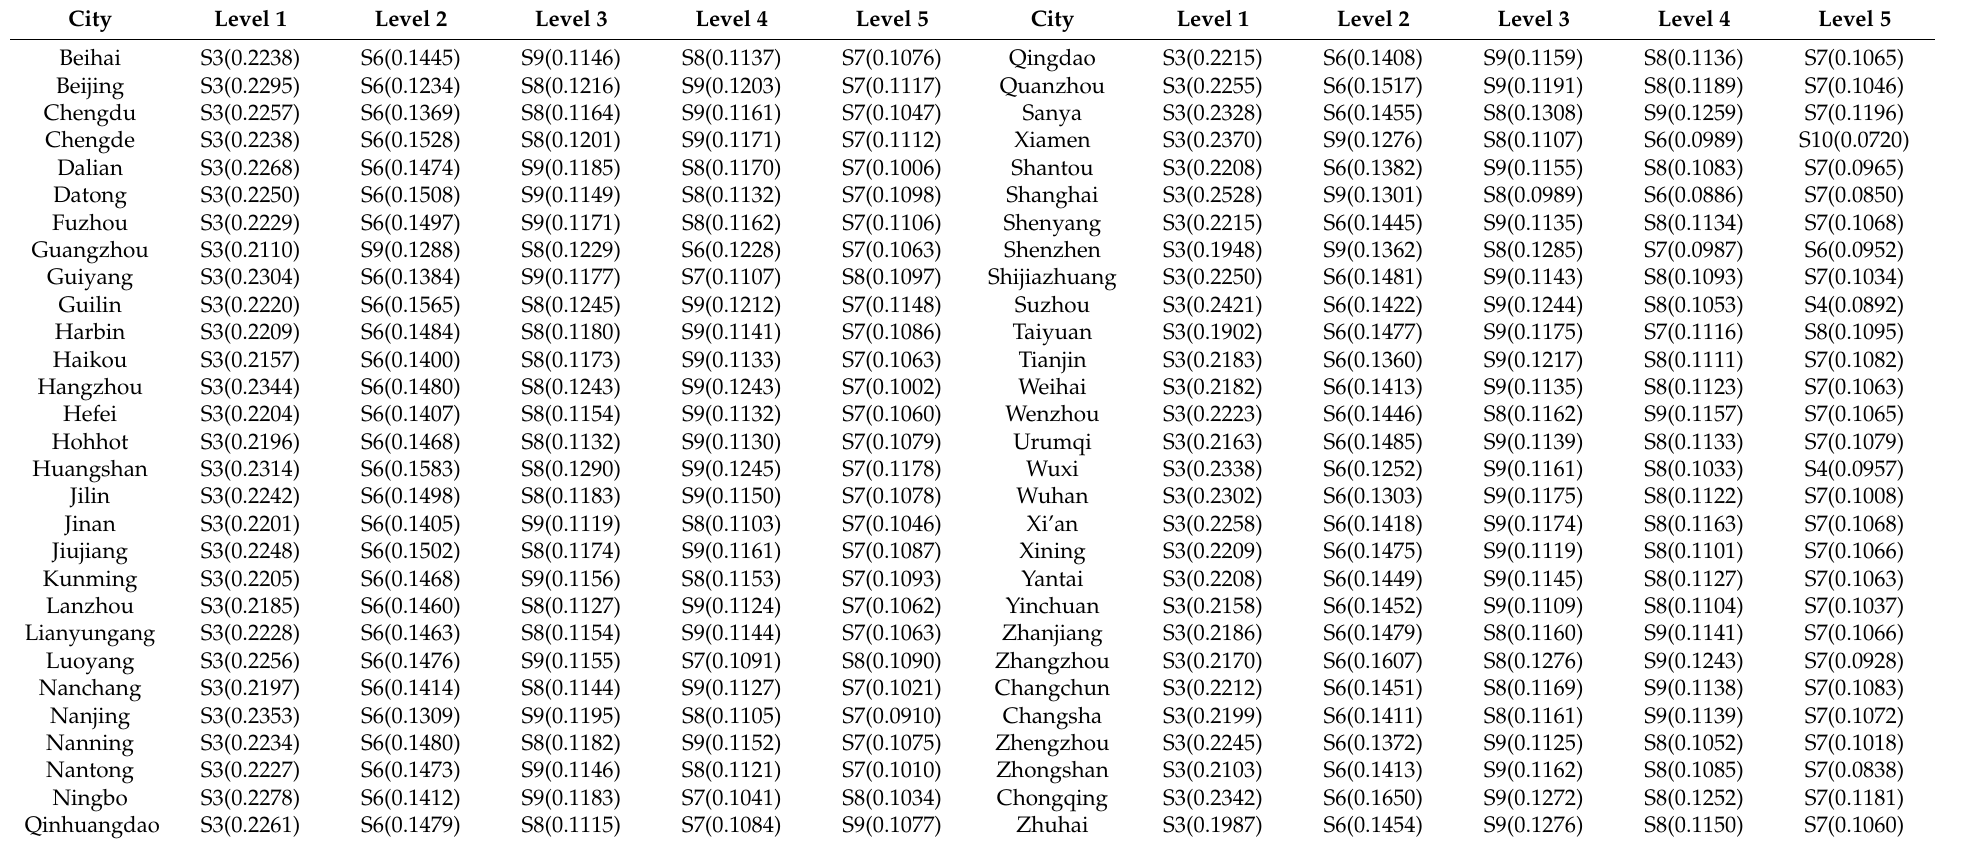
Table 3. Obstacle factors and obstacle degree of TEV of major tourist cities in